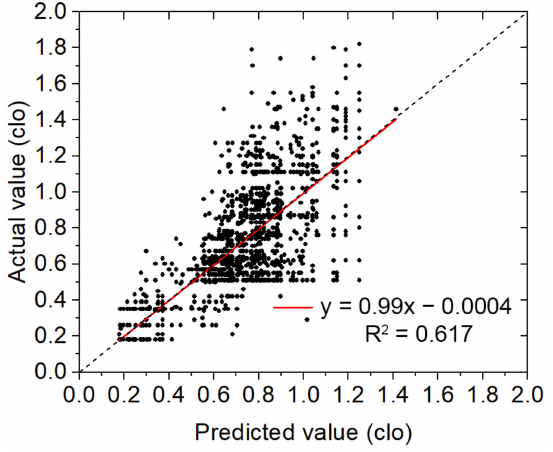
Figure 7. Relationship between predicted values and actual values of the entire dataset.